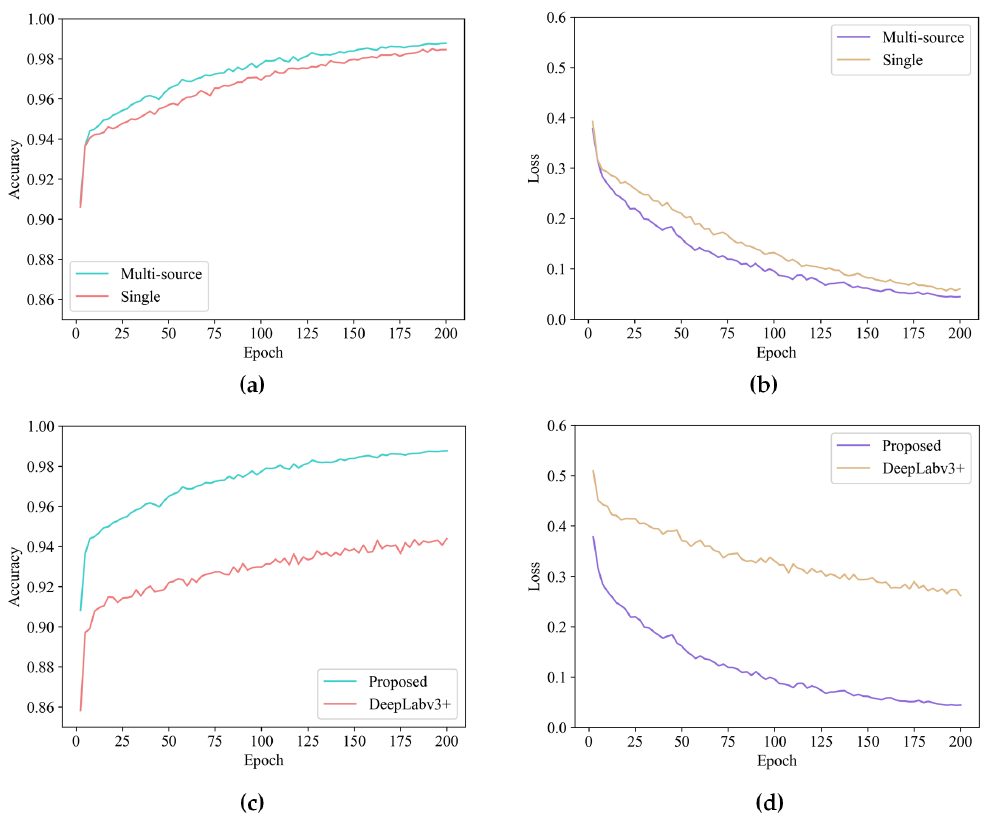
Figure 7. Comparisons of the training results. ( a , b ) are the comparative training results of single data and multisource data for the proposed network, and ( c , d ) are the comparative training results of the original DeepLabv3+ and the proposed network. Table 2. Quantitative evaluation with the ground-truth